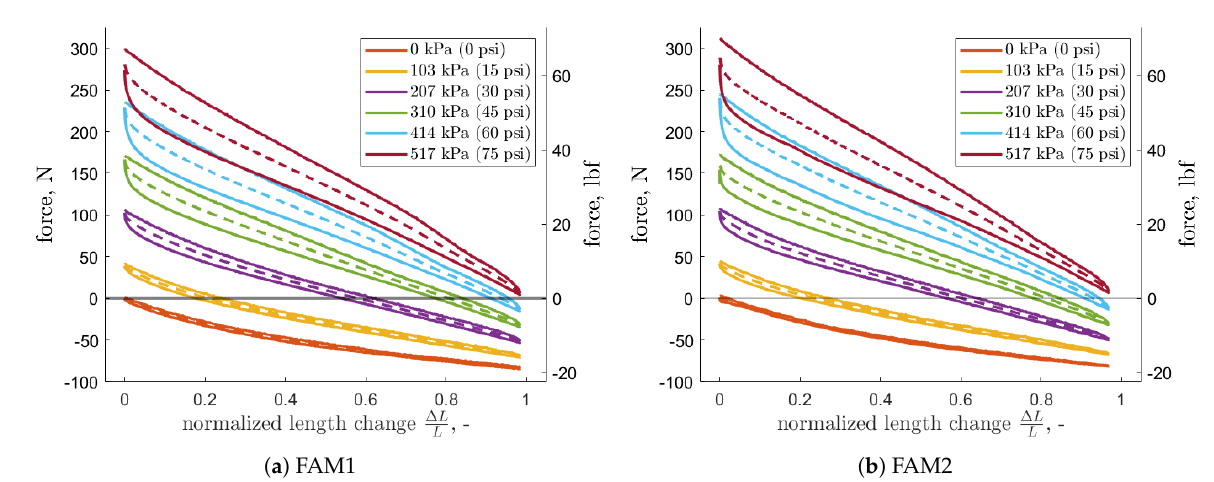
Figure 6. Quasi-static axial force response plot under isobaric conditions of FAM1 and FAM2. The data show hysteresis between parts of testing cycles with increasing and decreasing length